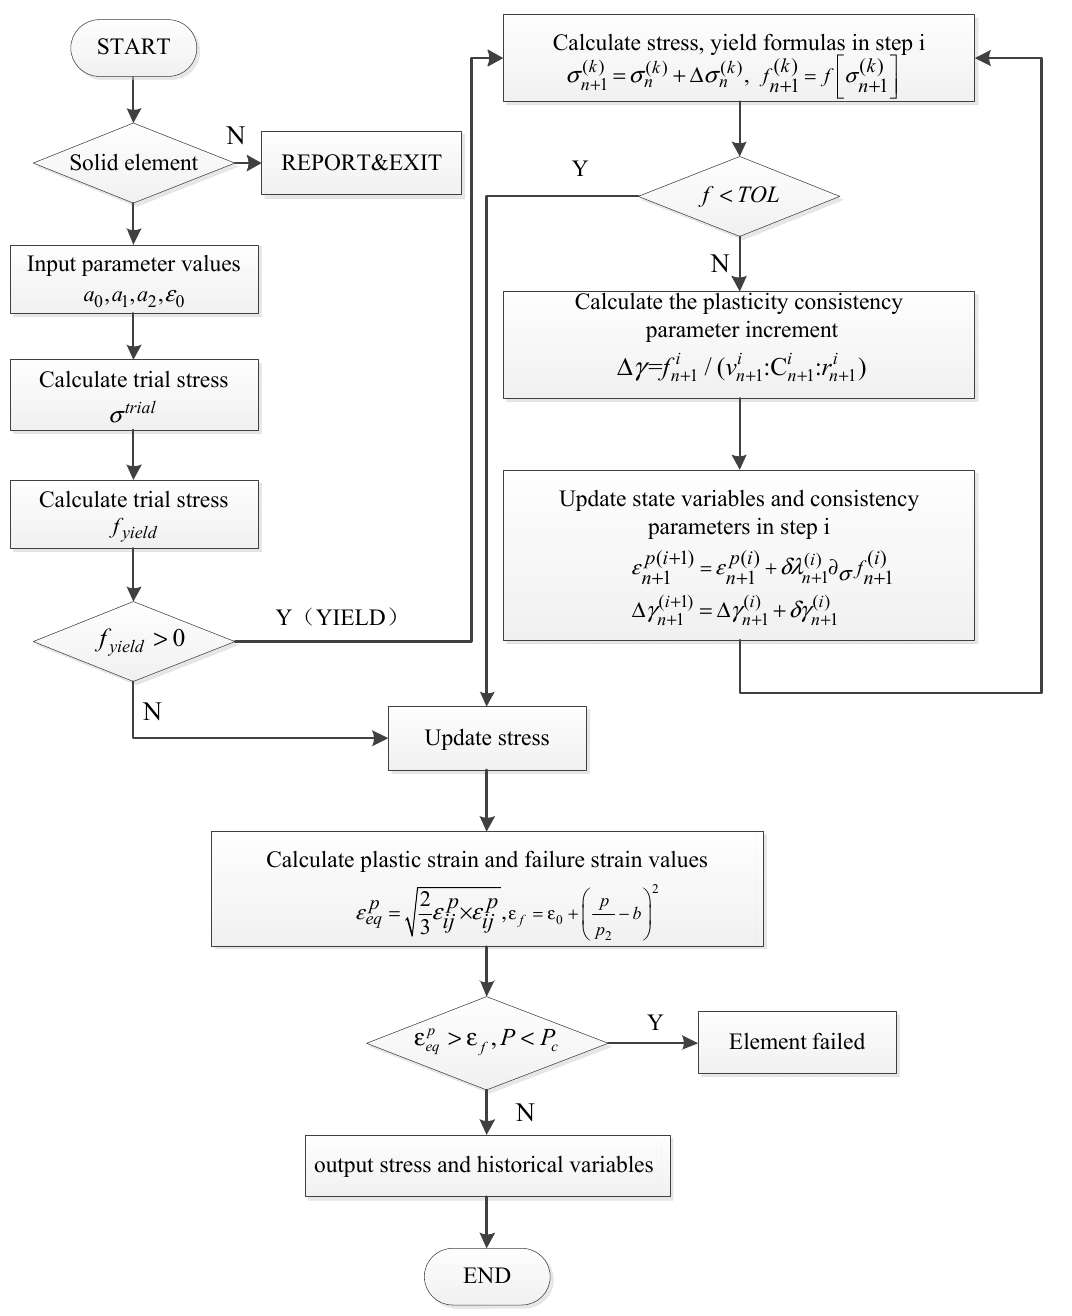
Figure 13. A flow chart of the algorithm of the subroutine.